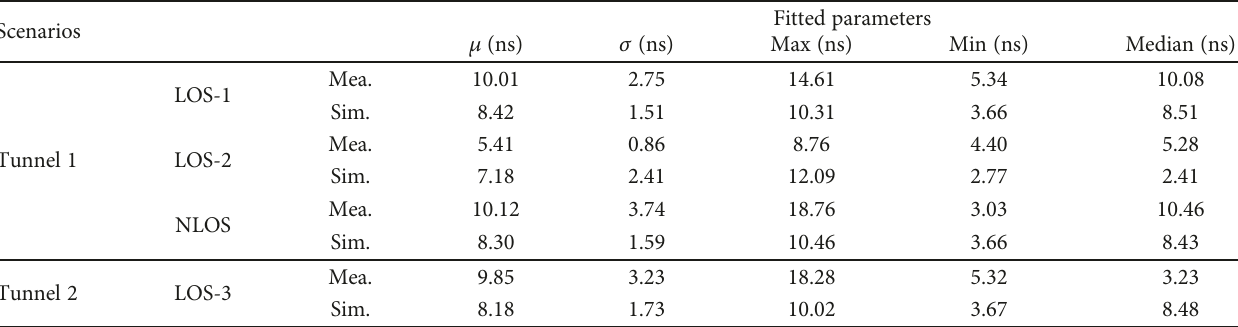
Figure 6: CDF for RMS delay spreads at 6GHz in LOS and NLOS tunnel scenarios. (a) LOS-1 path, (b) LOS-2 path, (c) LOS-3 path, and (d) NLOS Table 4: RMS delay spread values for all scenarios.